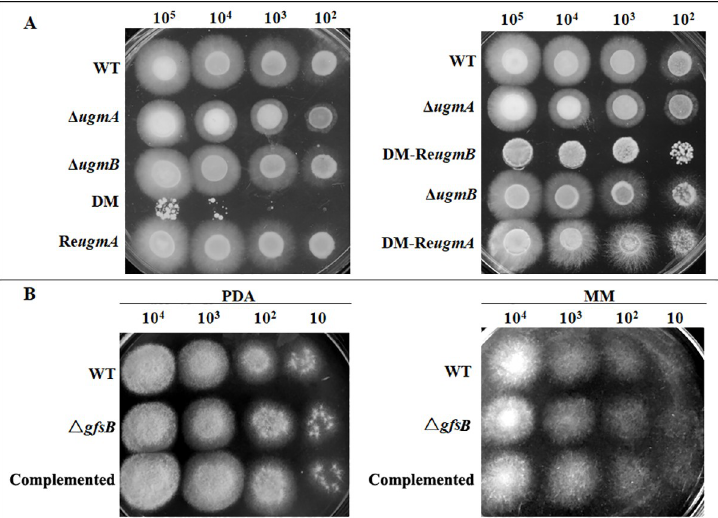
Fig 1. Growth of the mutant strains. Serial dilutions of conidia of 10 5 − 10 2 from the wild-type (WT), mutants and complemented strains were grown on PDA (A) or MM (A and B) plates at 28˚C for 7 days. DM, double-deletion mutant; DM-Re ugmB , double mutant with a copy of re-introduced ugmB ; DM-Re ugmA , double mutant with a copy of re-introduced ugmA . defect of the double mutant is more severe than that of the Δ ugmA . In contrast, the Δ gfsB mutant did not show any increased sensitivity to calcofluor white or Congo red (S3 Fig). These results suggest that the ugmA contibutes to the cell wall integrity, hyphal growth and conidiation, whereas the gfsB is not required.